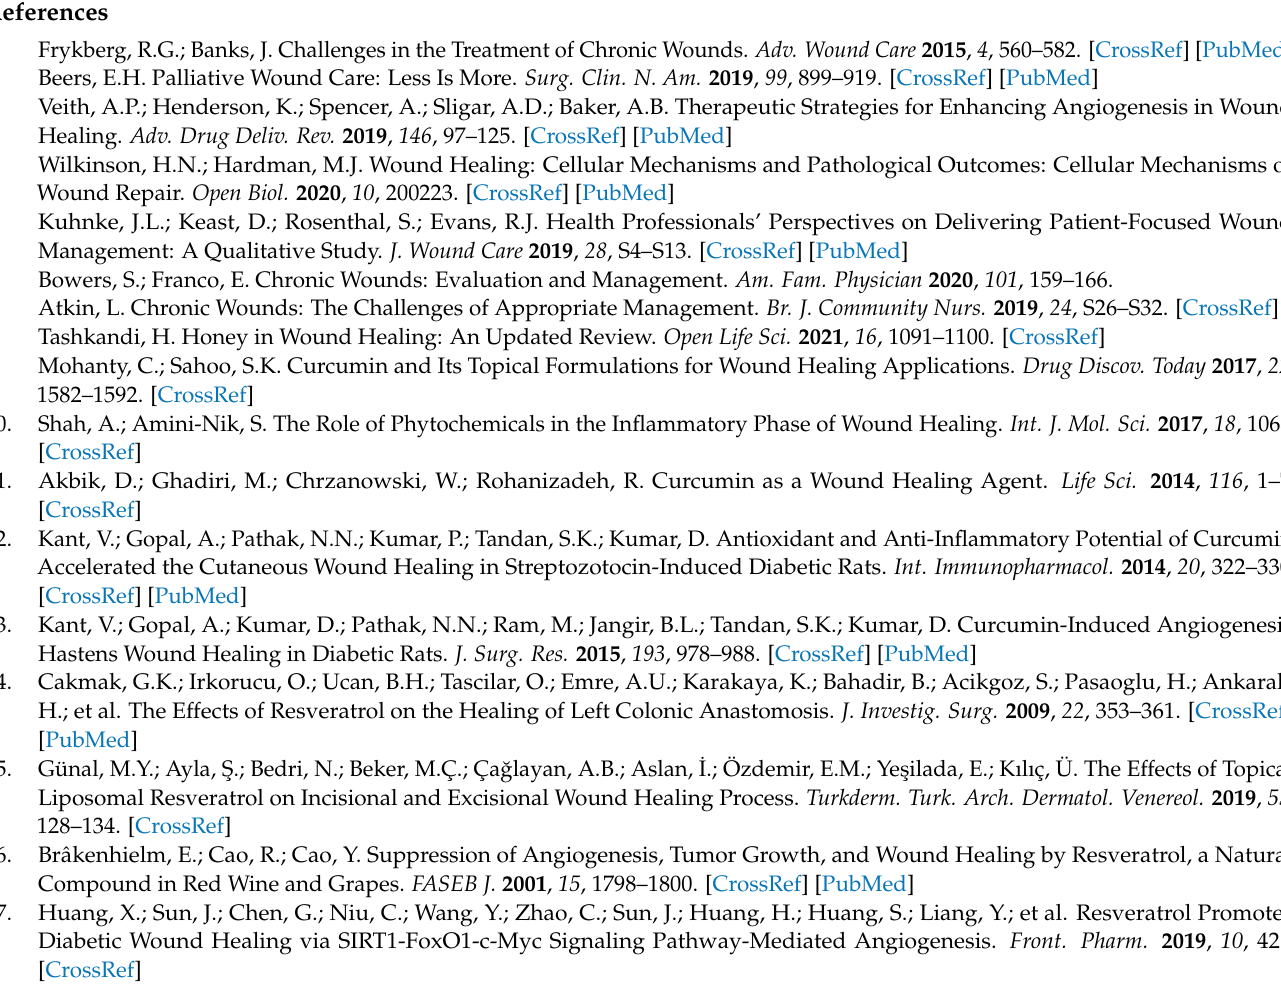
Table S2: MTT results for resveratrol – Balb3t3, Table S3: MTT results for baicalin – Balb3t3, Table S4: MTT results for curcumin – L929, Table S5: MTT results for resveratrol – L929, Table S6: MTT results for baicalin – L929, Table S7: ST results for curcumin – Balb3t3, Table S8: ST re- sults for resveratrol – Balb3t3, Table S9: ST results for baicalin – Balb3t3, Table S10: ST results for Table S13. Anderson – Darling test results, Table S14. T-test results for all